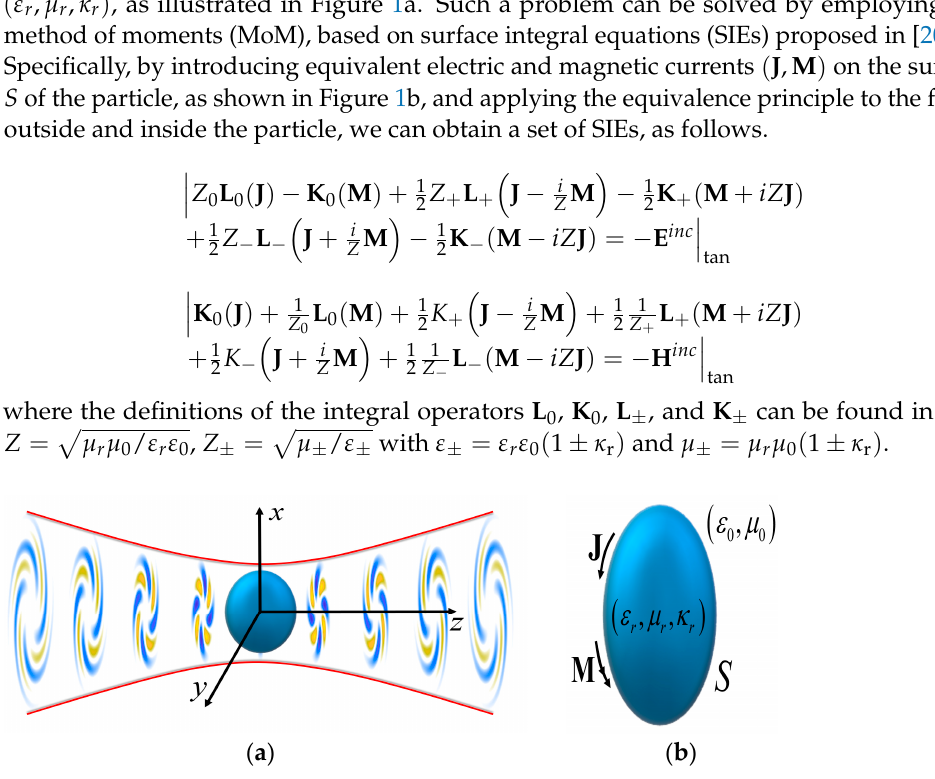
Figure 1. ( a ) Illustration of a homogeneous dielectric chiral particle illuminated by a twisted light. ( b ) Schematic of equivalent electric and magnetic currents.